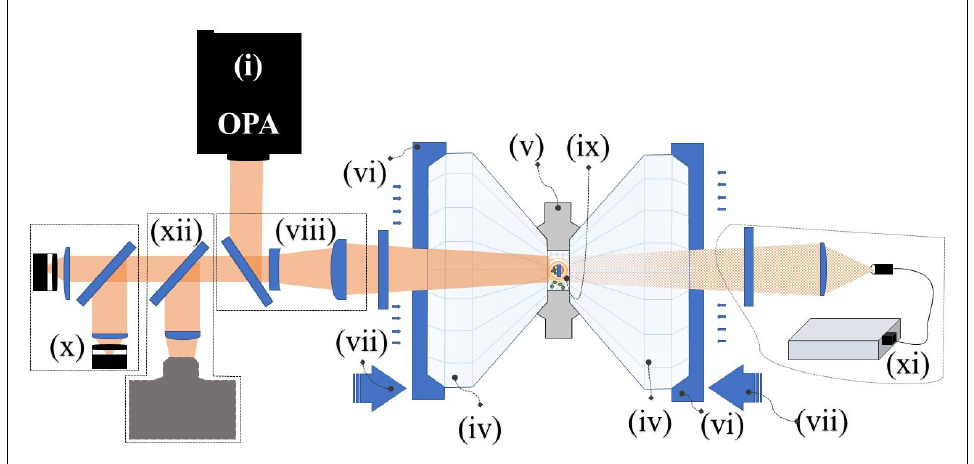
Figure 5. Typical arrangement of a Laser Reactive Synthesis Diamond Anvil Cell (LRS-DAC) for scientific or engineering experiments. The various components of this system are described in the text.